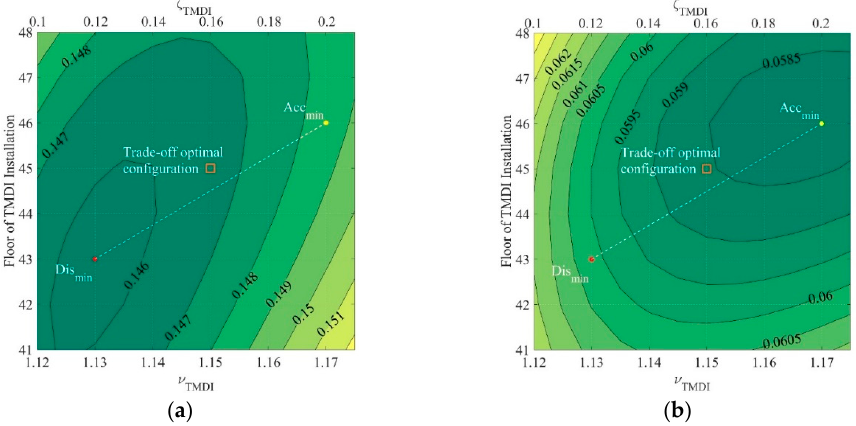
Figure 10. Contour of ( a ) peak displacement ( b ) peak acceleration with variable frequency ratio, damping ratio and floor of TID installation. Table 3. Design parameters of Tuned Mass Damper (TMD), Tuned Mass-Damper-Inerter (TMDI) and Tuned Inerter Damper (TID) used for the comparative study.